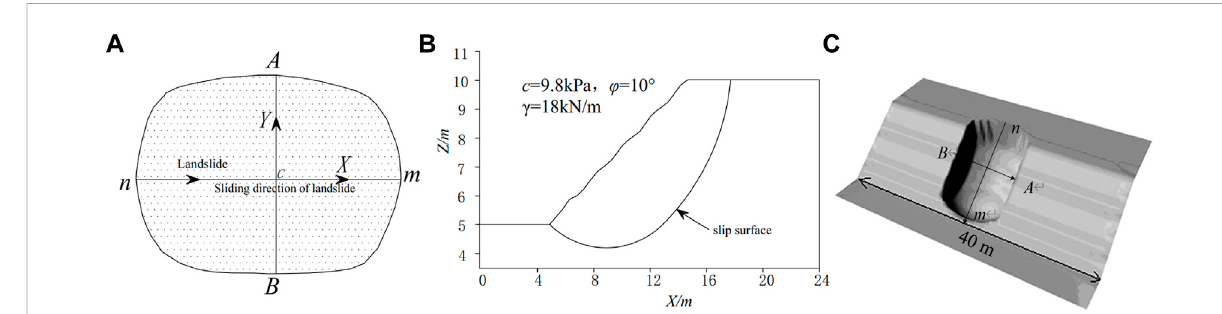
FIGURE 3 Plane and cross-section of slope. (A) plane of slope, (B) cross-section of slope, (C) the DEM model of slope